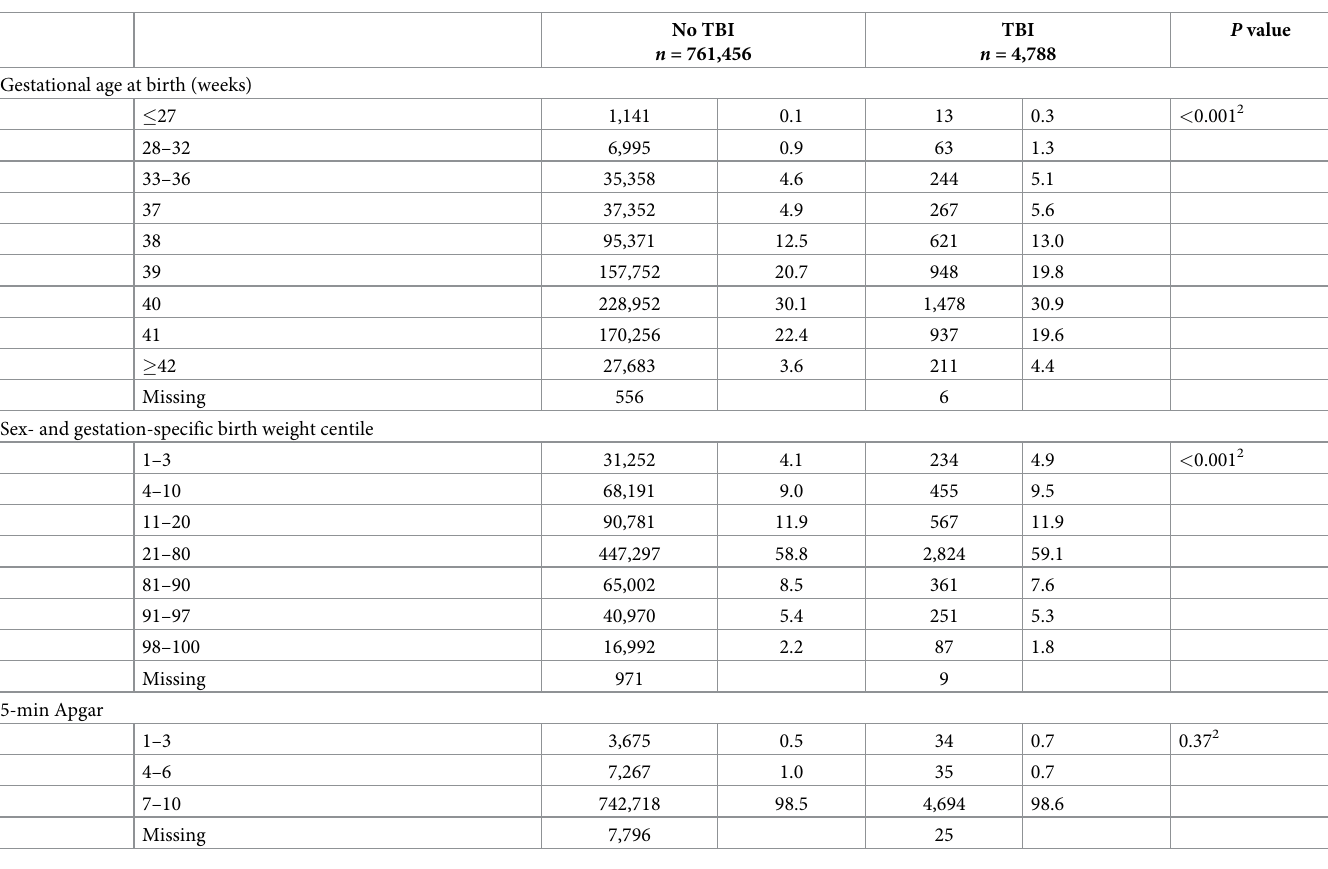
1 Produced using Chi square test for association.